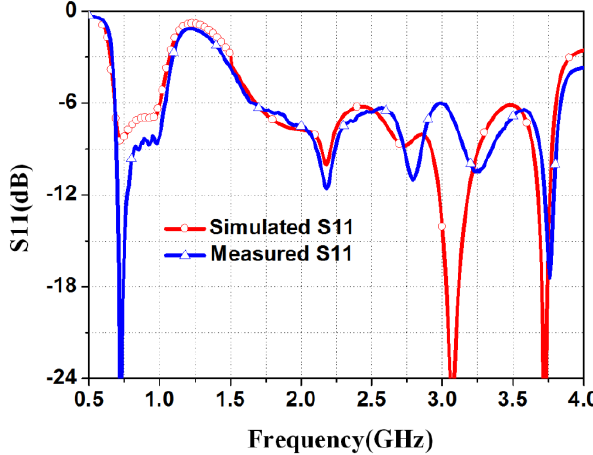
Figure 7. Photos of the fabricated antenna.